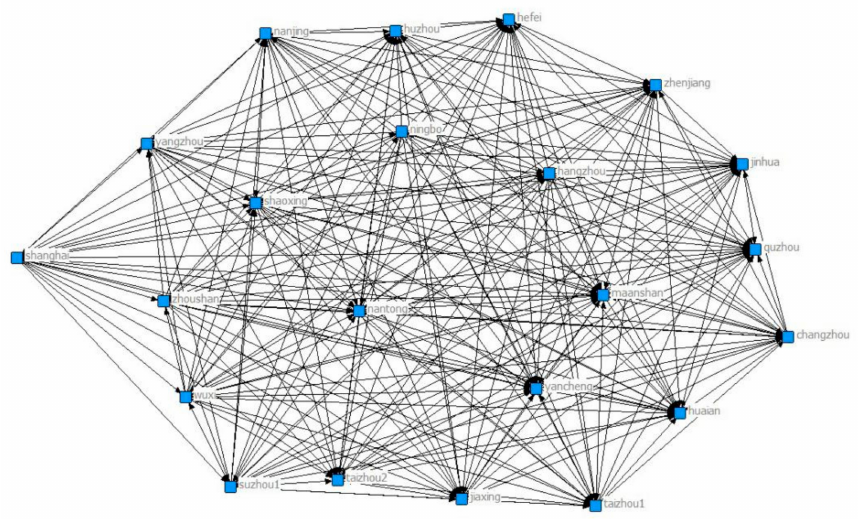
Figure 1. Yangtze River Delta collaborative network in